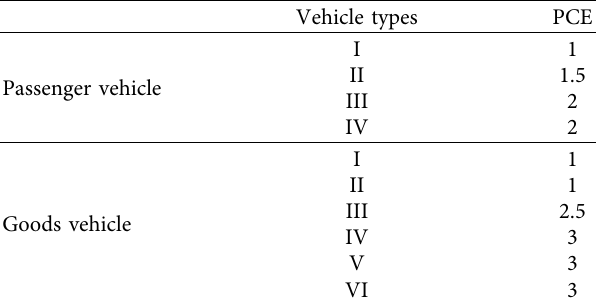
Table 2: PCE for diferent types of